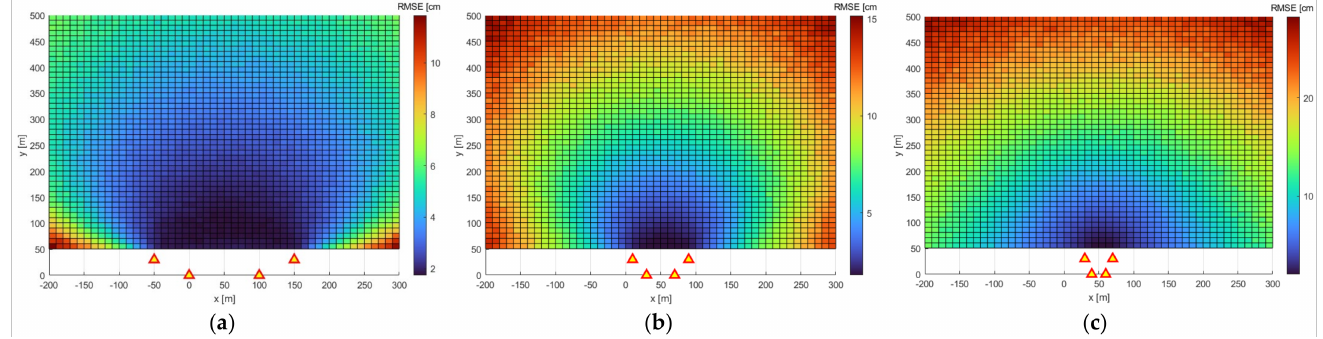
Figure 10. RMSE for different system configurations: ( a ) C1; ( b ) C2; ( c ) C3. As can be seen, the smallest positioning errors are achievable in front of the place, where the UWB stationary modules M 1 ÷ M 4 are located. The high-accuracy zone is wider and deeper for a more extended baseline of the positioning system. Mean and maximal RMSE values for the whole area of 450 m × 500 m and for smaller areas, limited to the nearest 100 m × 100 m and 50 m x 50 m respectively, in front of the UWB stationary modules M 1 ÷ M 4 are given in Table 2. Table 2. Mean and maximal RMSE values for areas of various sizes.